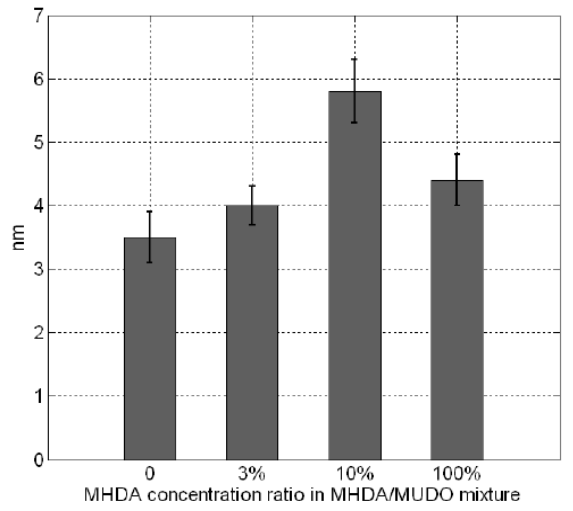
Figure 8. Thickness of the combined thiolate and protein layer, measured for each chemical